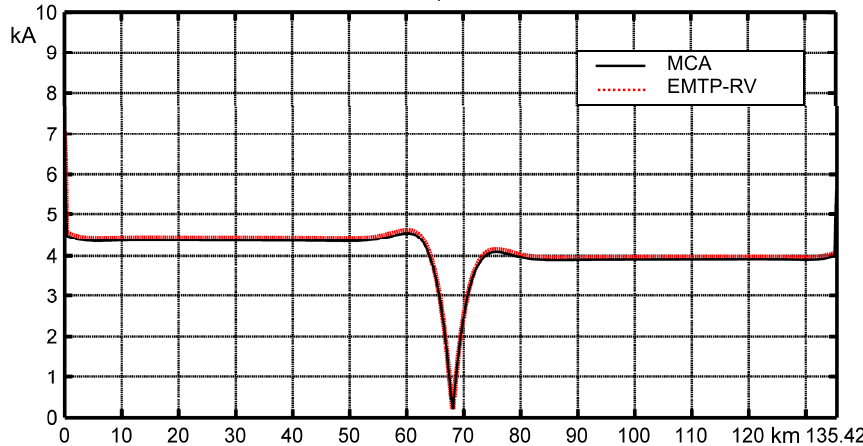
Figure 22. Ground return current comparison between the MCA and EMTP-RV under line-to-earth short circuit in a double-circuit